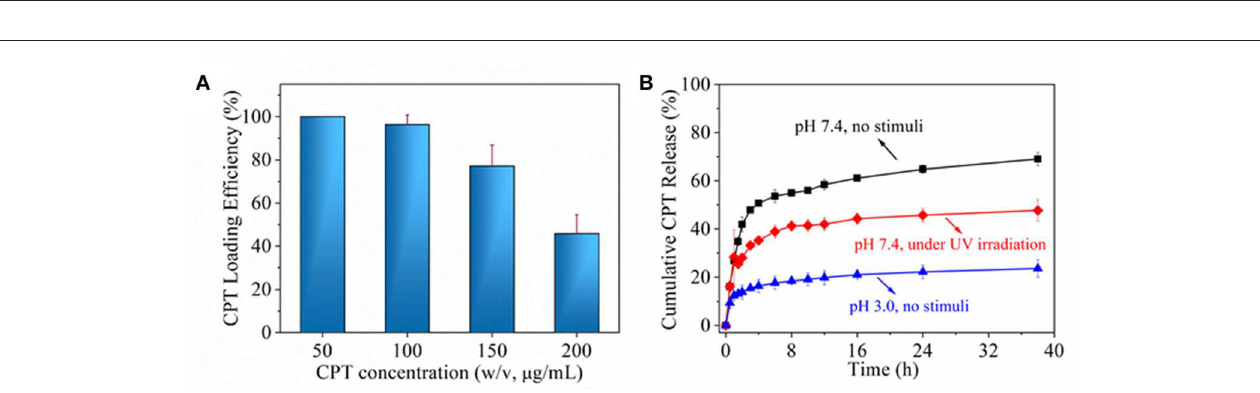
FIGURE 6 | (A) CPT loading efficiency as a function of CPT concentration. (B) cumulative CPT release under different environment.